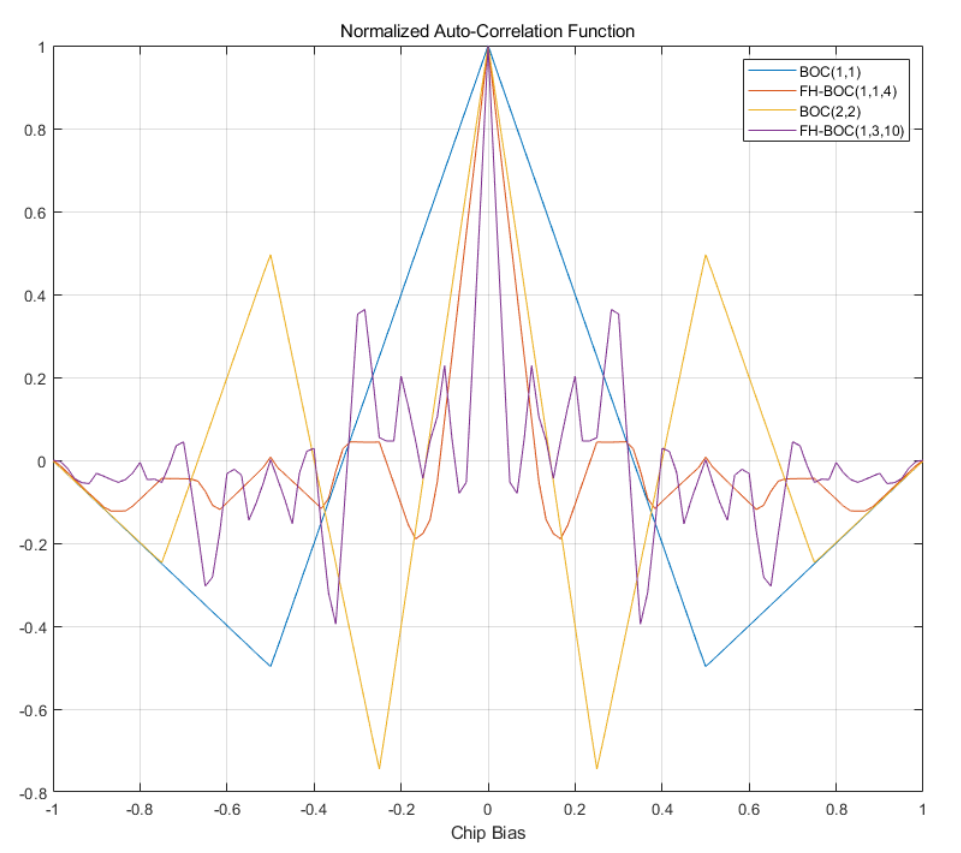
Figure 5. ACF comparison between FH-BOC signals and BOC